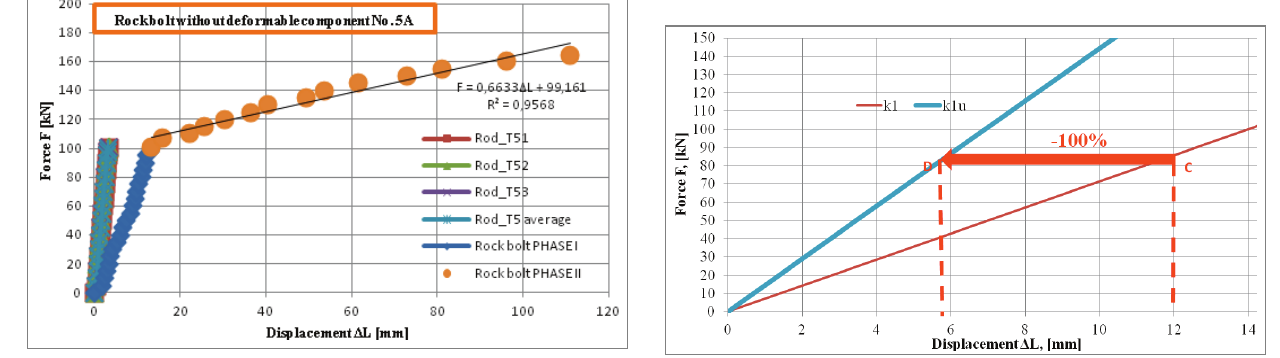
Fig. 37. The impact of the deformable component